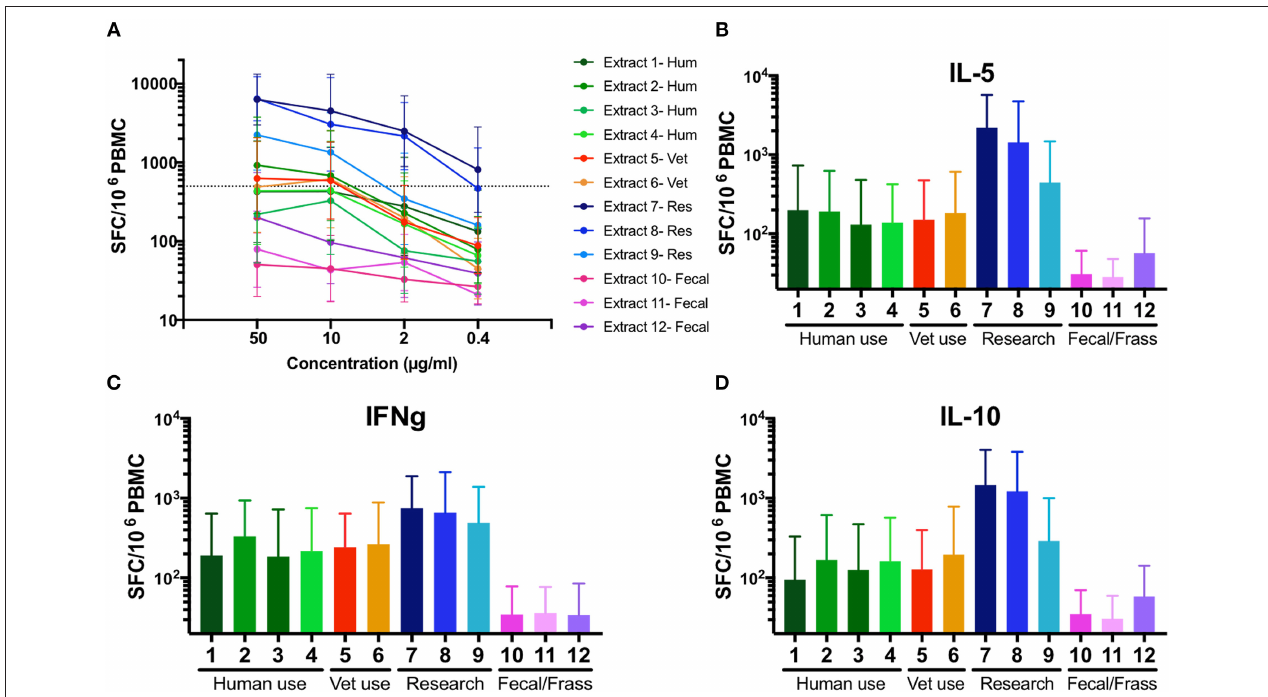
FIGURE 2 | Variability in T cell potency and cytokine polarization in 12 different German cockroach extracts. (A) A line graph showing T cell reactivity (sum of IL-5, IFN γ , and IL-10 production) in response to 12 different preparations of German cockroach extract, measured in 5-fold titration steps (0.4, 2, 10, and 50 µ g/ml). A dotted line indicates potency of extract to induce a T cell response of 500 spot forming cells (SFC). Geometric means 13 tested donors are shown, with error bars indicated 95% confidence interval (CI). (B–D) Bar graphs showing the IL-5, IFN γ , and IL-10 production. Bars indicate geometric means of 13 donors, with error bars indicating 95% CI. N = 13.